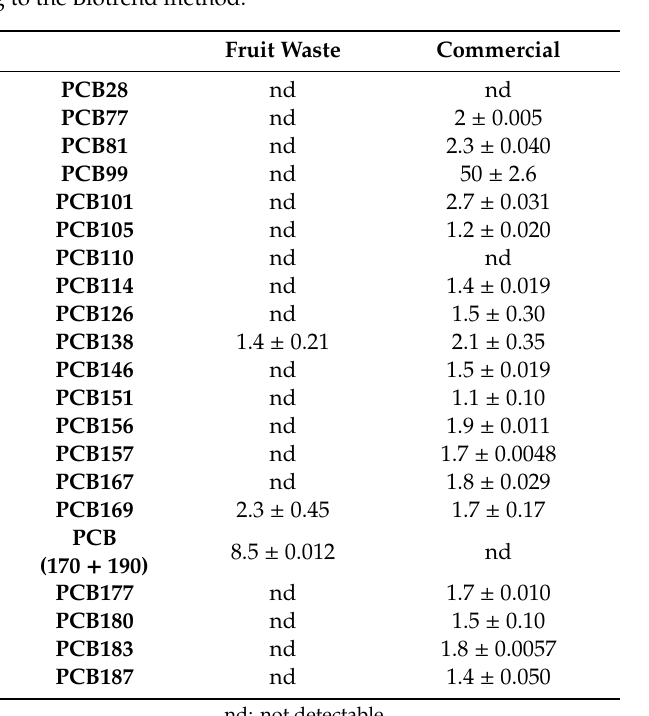
Table 4. Concentrations ( µ g / kg) of PCBs in commercial PHA and in PHA samples from fruit waste extracted according to the Biotrend